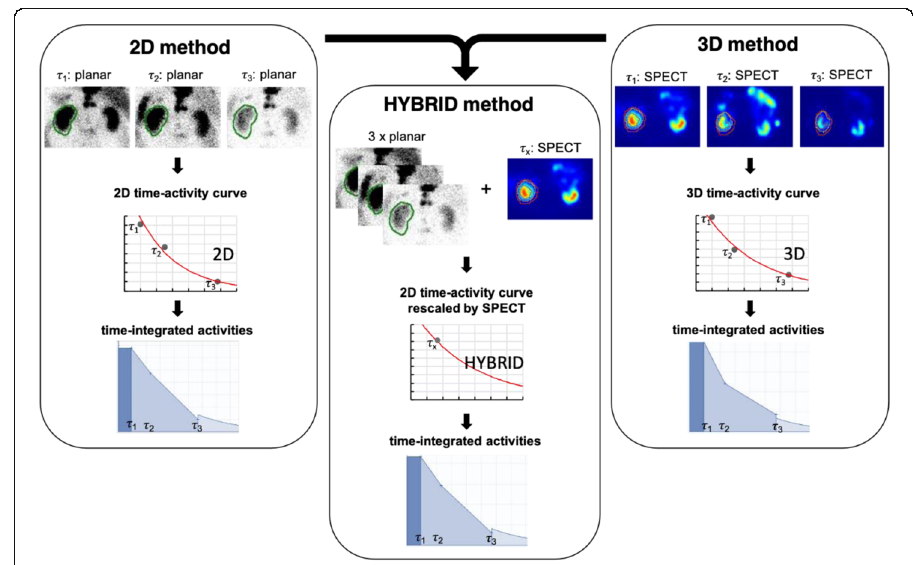
Fig. 1 Schematic dosimetry workflow for the three different methods exemplarily shown for the data of the kidney. Absorbed dose estimation was performed by use of the software platform